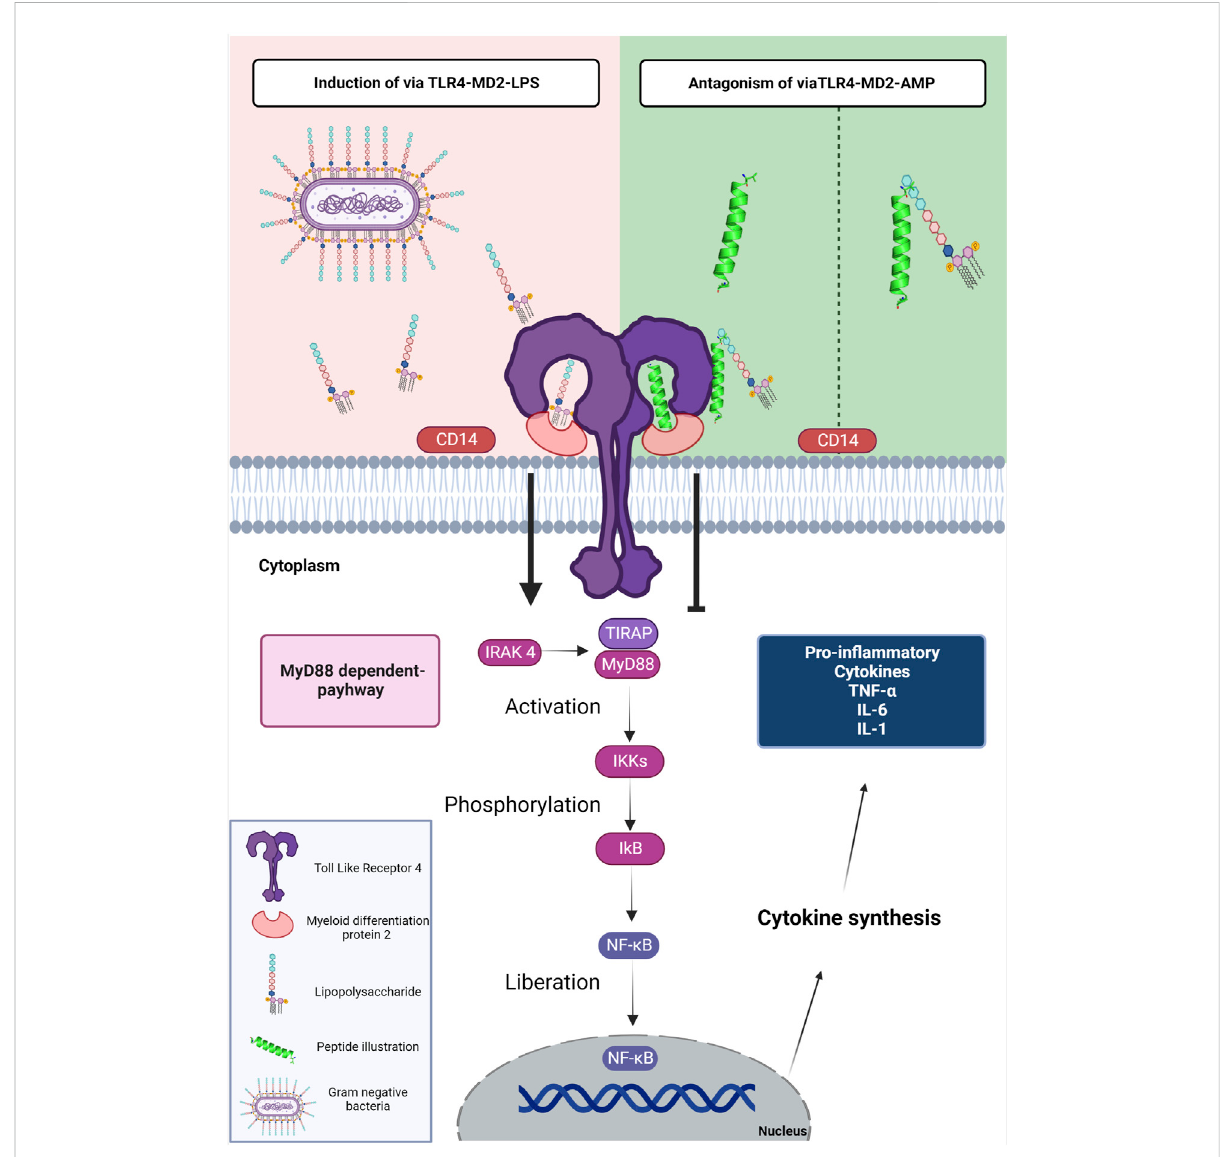
FIGURE 1 Schematic representation of the mechanism of LPS, AMPs and TLR4. The LPS present in gram-negative bacteria is detected by the CD14 protein. TLR4 uses an accessory protein, MD-2, which performs the function of correctly directing TLR4 to the cell surface, thus recognizing LPSandformingtheTLR-4-MD-2complex(induction via TLR4-MD2-LPS).AftertheinteractionofLPSwithTLR-4,conformationalchangesoccurin the receptor that leads to the approximation of two adapter proteins in the intracellular portion; TIRAP and MyD88. In this way, the signaling cascade is activated by the MyD88-dependent pathway; this cascate starts when MyD88 along with IRAK 4 stimulate the activation of IKKs and then phosphorylation of IkB, to fi nally realese the NF-kB. Thus, NF- κ B is translocated to the cell nucleus, inducing the transcription of genes associated with the in fl ammatory response. The genes are responsible for the expression of mediators: TNF- α , IL-6, IL-1 β , IFN- γ , chemokines, and adhesion molecules.TheTLR4-MD2-AMPpathway canmediateTLR-4signalingintwoways.The fi rstisinteractingwithLPS;preventingtheencounterofLPS with CD14 and subsequently the TLR-4-MD-2 complex. The second way is the interaction of AMPs with TLR4 which occupies the binding site and prevents the interaction of LPS with the TLR-4-MD-2 complex. The interaction of AMPs with the LPS or TLR-4-MD-2 complex shows antagonistic activity to the MyD88-dependent signaling pathway. Figure created with